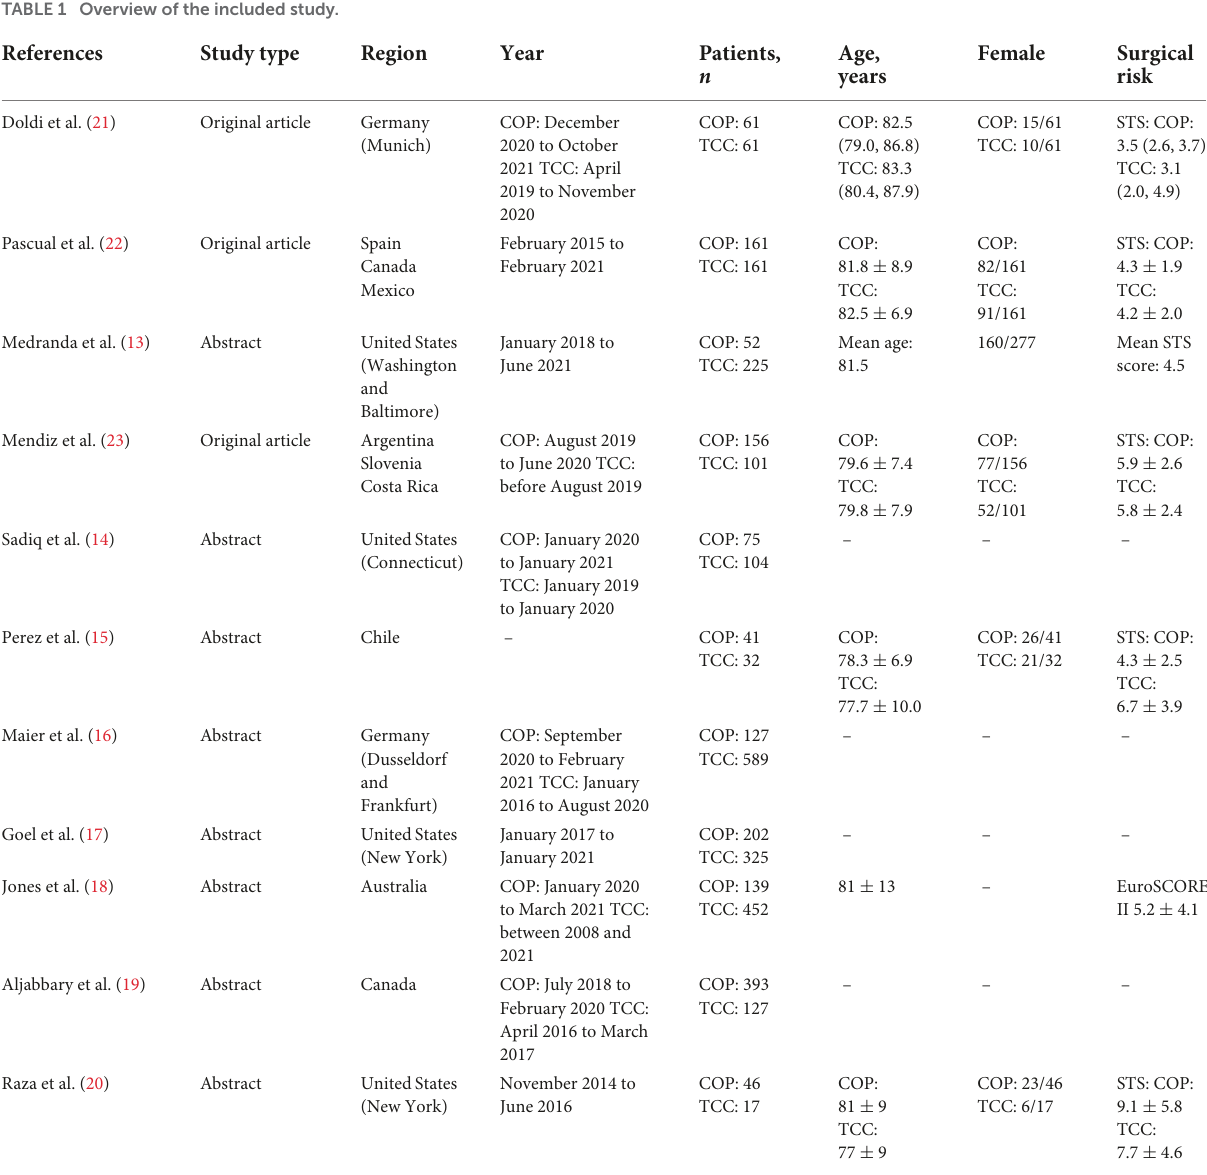
TABLE 1 Overview of the included